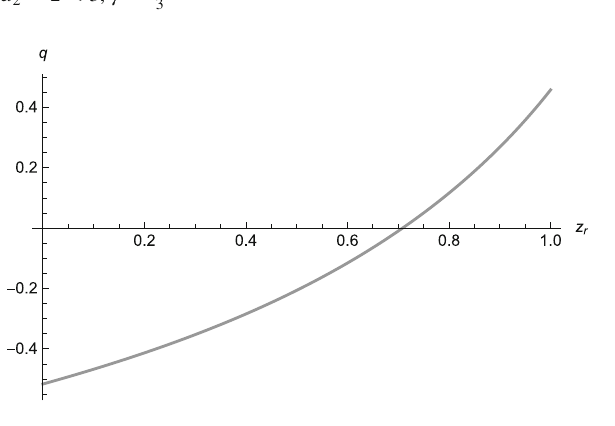
Fig. 7 The graphical behaviour of H ( z r ) in redshift with b 1 = 10 13 , α = 2 < 3, γ = 4 2 3